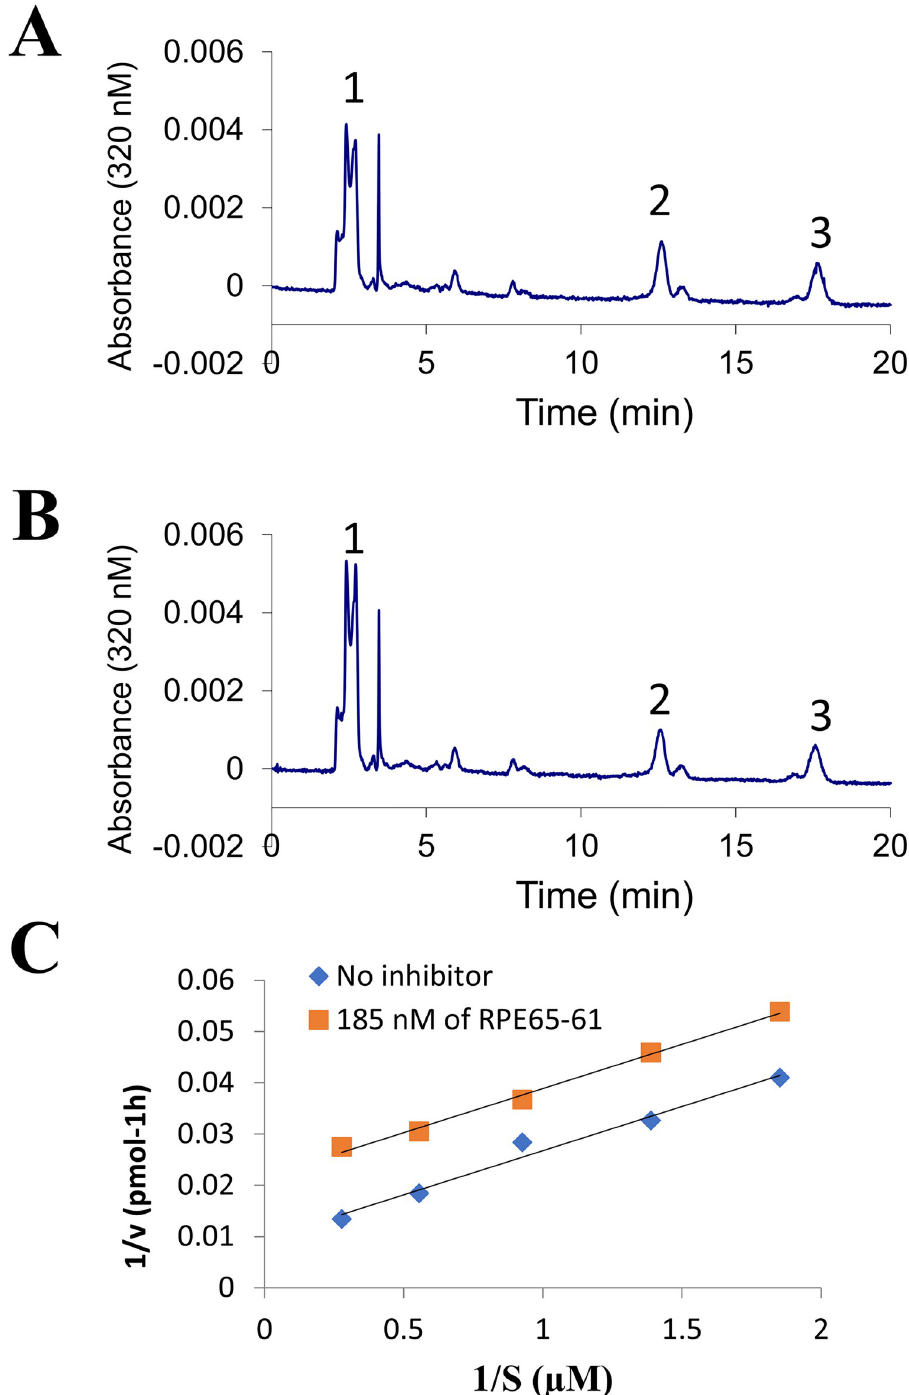
Fig 3. Uncompetitive inhibition of RPE65 isomerase by ( ± )-RPE65-61 in the liposome-based assay. All- trans - retinyl ester incorporated in liposomes was used as a substrate for purified RPE65 in the isomerase assay. (A). HPLC elution profile of the reaction products without inhibitor. (B) with 180 nM of ( ± )- RPE65-61 ; Peak 1, retinyl esters; 2, 11- cis -retinol; 3, all- trans -retinol. (C) Lineweaver-Burk plot of 11- cis -retinol generated by RPE65. Liposomes with increasing concentrations (S) of all- trans -retinyl palmitate were incubated with 25 μ g of purified chicken RPE65 in the absence ( ♦ ) or in the presence of ( ± )-RPE65-61 (180 nM) ( ■ ).